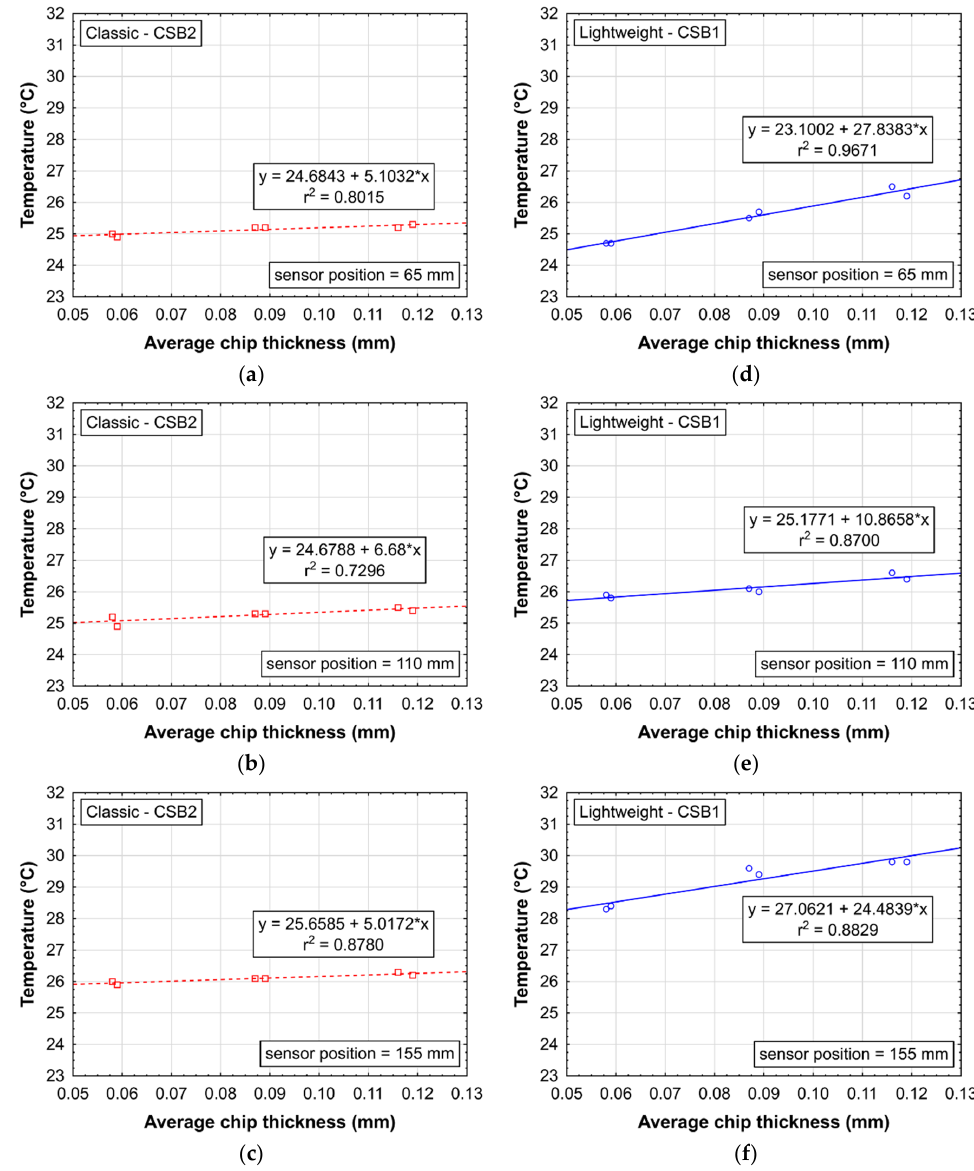
Figure 11. Dependence between the surface temperature of the circular saw blade and the average chip thickness when cutting classic and lightweight plywood: ( a ) classic plywood, CSB2, sensor position 65 mm; ( b ) classic plywood, CSB2, sensor position 110 mm; ( c ) classic plywood, CSB2, sensor position 155 mm; ( d ) lightweight plywood, CSB1, sensor position 65 mm; ( e ) lightweight plywood, CSB1, sensor position 110 mm; ( f ) lightweight plywood, CSB1, sensor position 155 mm. The highest coefficient of determination between the surface temperature and the average chip thickness was obtained in the case of the lightweight plywood using a CSB1 circular saw blade (r 2 = 97%), as shown in Figure 10; Figure 11 shows that the high tight- ness is ensured by the value 80% ≤ r 2 [47]. The lowest coefficient of determination between the surface temperature of the circular saw blade and the average chip thickness was ob- tained in the case of classic plywood using the circular saw blade CSB2 (r 2 = 73%). Equa- tion (1) shows that in the case of both materials, an increase in the feed speed rate